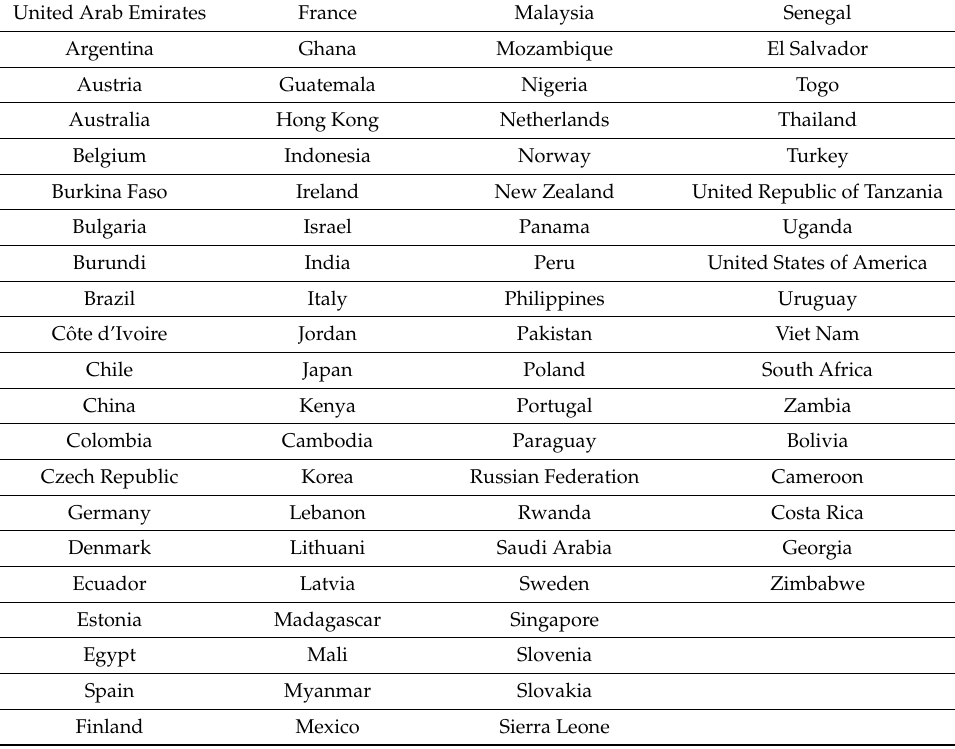
Table A1. The list of countries included in our